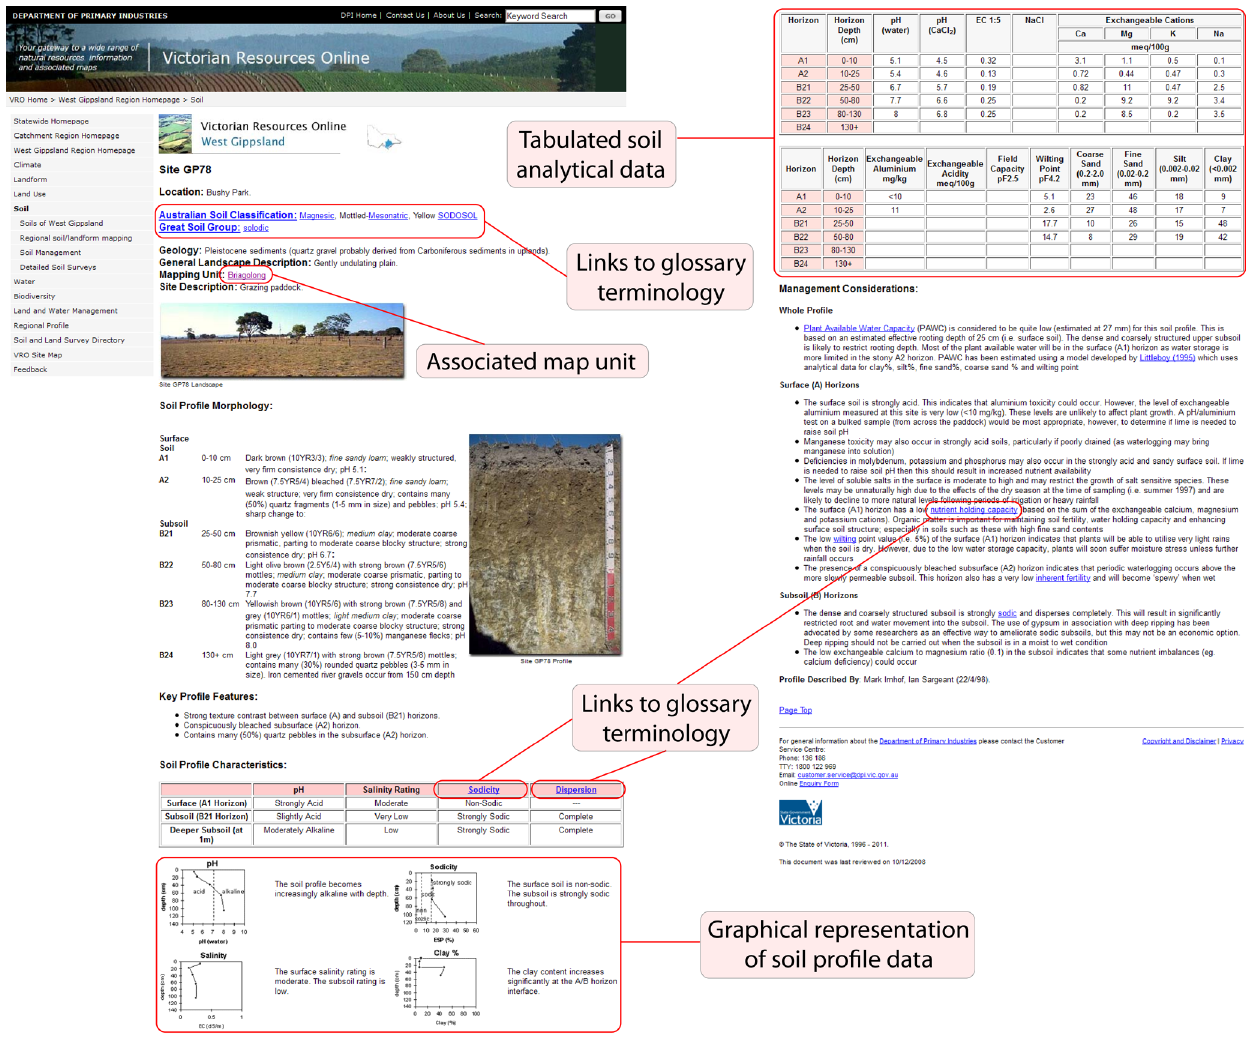
Figure 11. Presentation of a soil site description web page with annotated examples of data and information presentation and linking.  State of Victoria, Department of Primary Industries 1997 Reproduced with